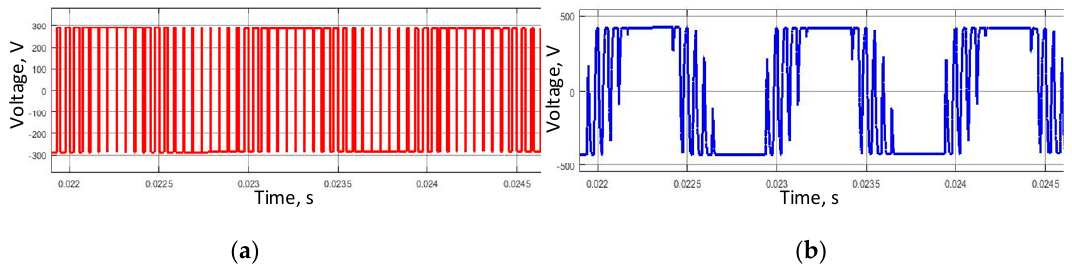
Figure 7. Voltages on the high frequency (HF) transformer: ( a ) the primary winding; and ( b ) the secondary winding.